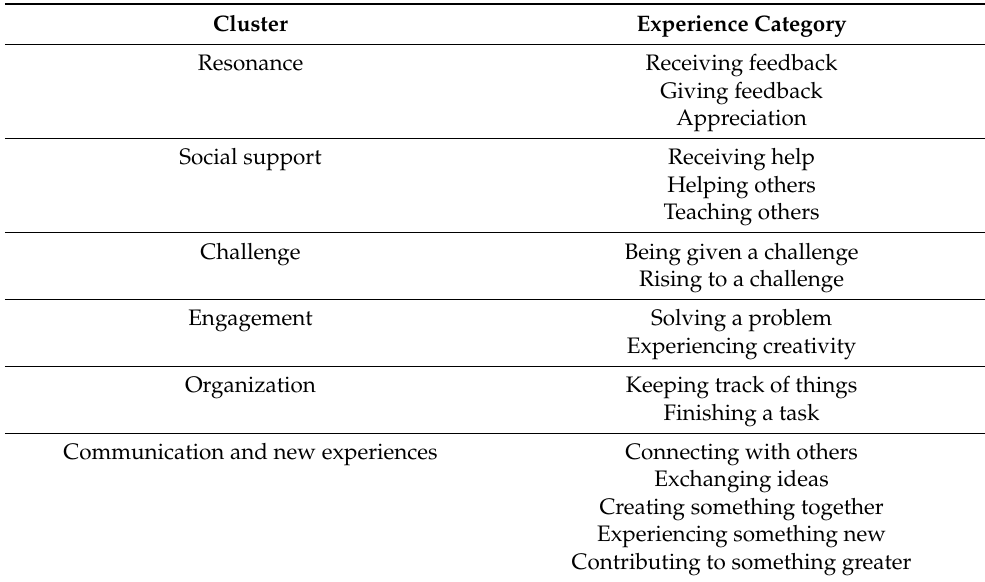
Table 1. Experience Categories in work contexts according to Zeiner et al.